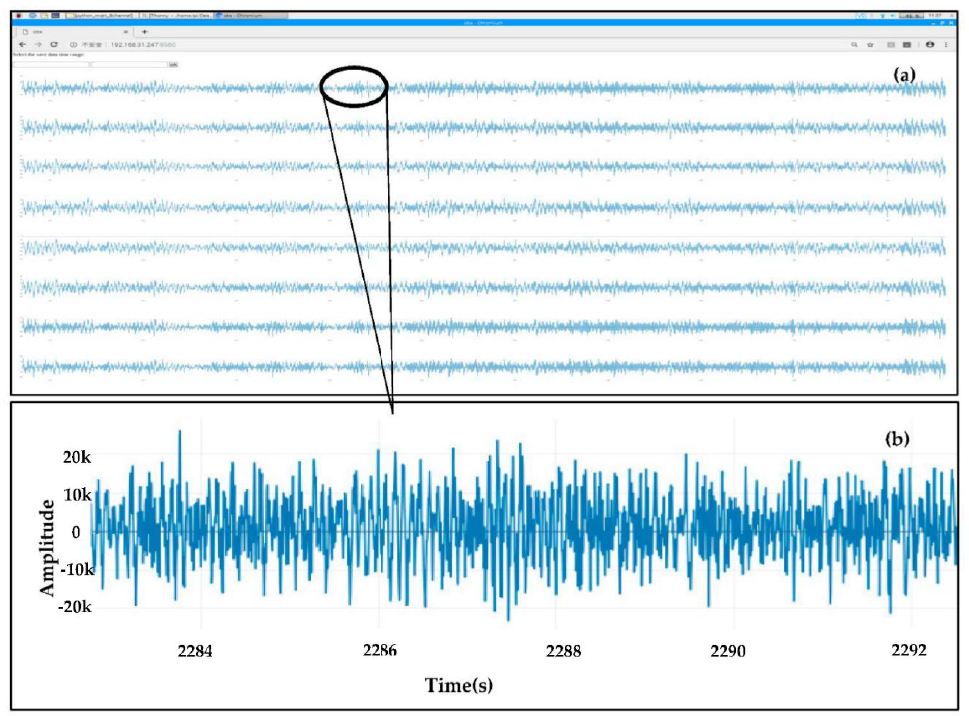
Figure 9. Screenshots from live streams of the seismic waveforms for the eight-channel seismograph running on the web browser of the Raspberry Pi. ( a ) Generated from ambient noise. ( b ) A zoomed-in section of channel 1.